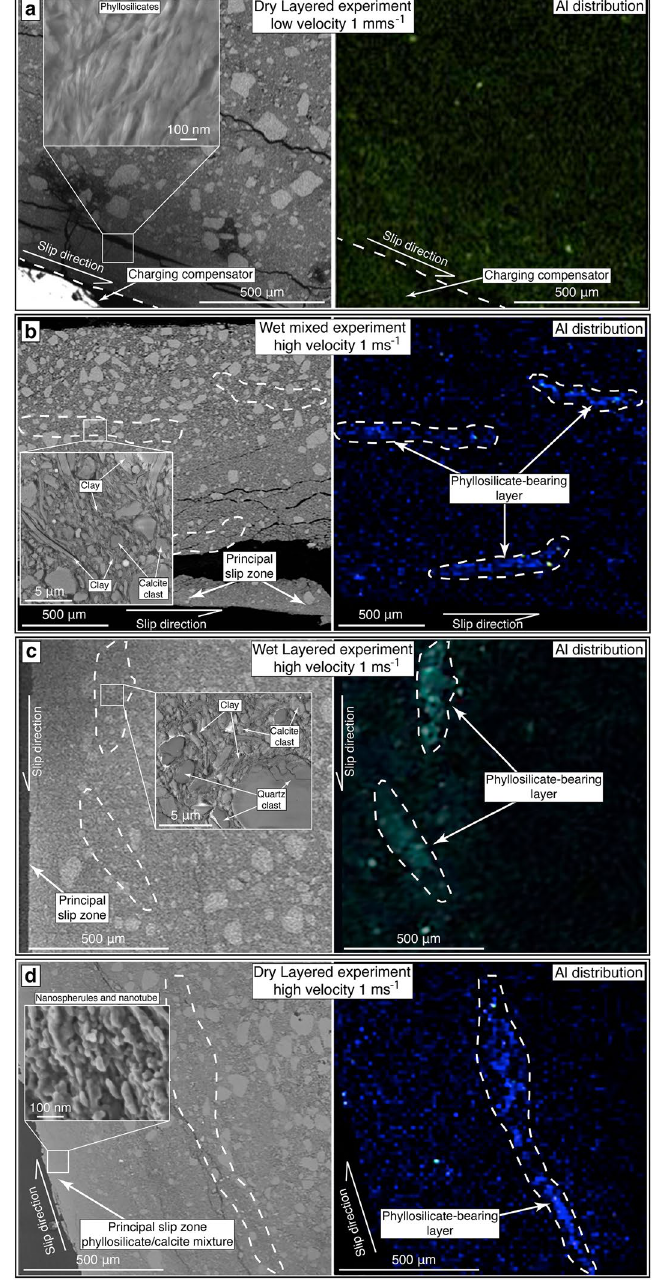
Figure 4. Experimental microstructures. (a) Left: FE-SEM image of dry layered gouge experimentally-sheared at subseismic velocity (0.001 ms − 1 ). Grain size reduction occurs toward the principal slip zone. Inset shows a detail of phyllosilicate lamellae showing no nanospherules or nanotubes that occur, in contrast, in samples from experiments at seismic velocity (see d ). Right: EDS map showing no concentration and segregation of phyllosilicates along distinct layers that occur, in contrast, in samples from experiments at seismic velocity (see b–d ). FE-SEM image of (b left ) wet mixed gouge experiment and (c left ) wet layered gouge experiment sheared at seismic-slip velocity (1 ms − 1 ) showing grain size reduction toward the principal slip zone. EDS map shows segregation and concentration of phyllosilicates along micrometer-thick layers both for mixed ( b right) and for layered ( c right) gouges under wet conditions. Insets show carbonate clasts within phyllosilicate- bearing layer wrapped by phyllosilicates. (d) Left: FE-SEM image of dry layered gouge experiment sheared at seismic-slip velocity (1 ms − 1 ) showing, toward the principal slip surface, grain size reduction and compaction stronger than wet gouges. Inset shows the nanostructures from the principal slip zone. These structures consist of clumped and chained nanospherules and nanotubes identical to those observed within phyllosilicates along the Tre Monti principal fault (see Fig. 2e and f). Right: EDS map showing concentration and segregation of phyllosilicates along a micrometer-thick